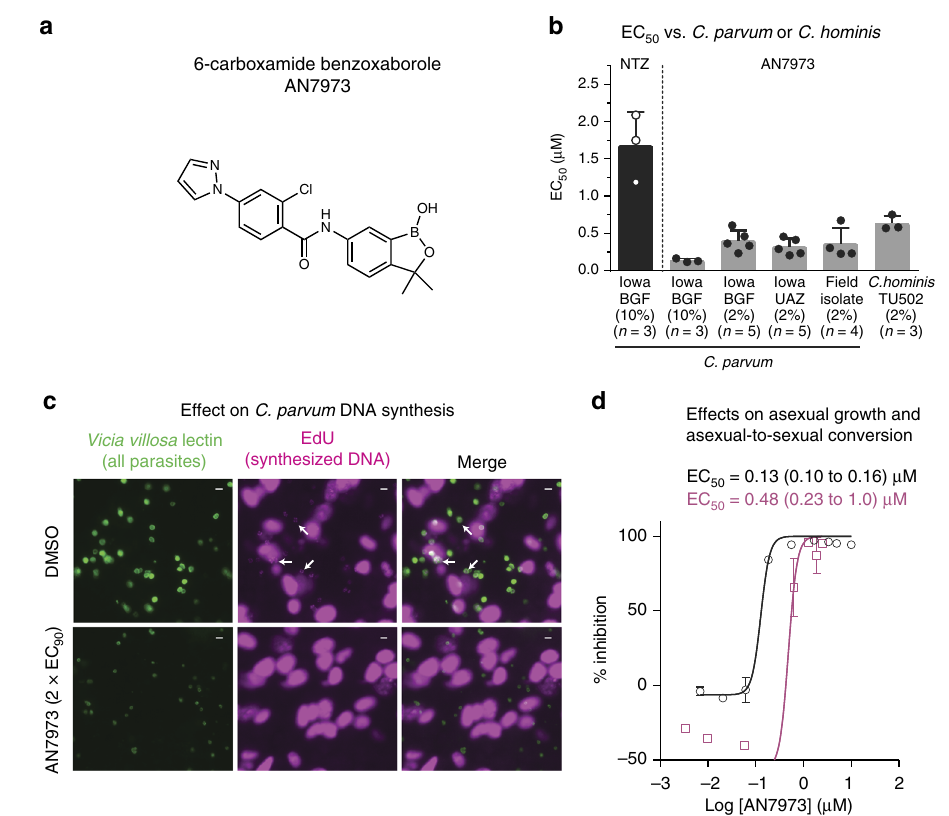
Fig. 2 AN7973 inhibits intracellular Cryptosporidium replication. a Structure of the 6-carboxamide benzoxaborole lead AN7973. b In vitro ef fi cacy of AN7973 against various C. parvum isolates and the C. hominis TU502 isolate grown within HCT-8 cells. Nitazoxanide (NTZ) is included as a positive control. BGF Bunch Grass Farms, UAZ University of Arizona. The percent fetal bovine serum present in the medium and number of replicates for each assay are given in parentheses. Data are the mean and SD. Assays for c through d were performed in 10% FBS. c Effect of AN7973 on intracellular DNA synthesis. C. parvum (Bunch Grass Farms Iowa isolate) infected host cell monolayers were incubated in the presence of the thymidine analog EdU, and AN7973 (2 × EC 90 = 0.42 µ M) or DMSO (control). All parasites are shown in green ( Vicia villosa lectin staining) and newly synthesized DNA (incorporated EdU) is shown in cyan. Arrows indicate EdU positive parasites, which are seen only in the absence of AN7973. Representative images from 2 independent experiments are shown. Scale bars are 5 µ m. d Potency of AN7973 against asexual growth (0 – 48 h (black line and circles)) and asexual-to-sexual conversion (48 – 72 h (cyan line and squares)) of C. parvum (Bunch Grass Farms Iowa isolate). Data are the means and SD for each concentration with